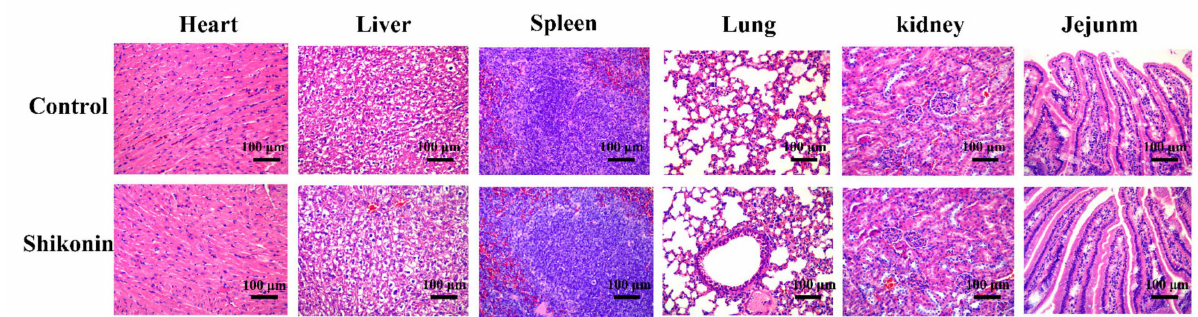
Figure 10. The major organs slice morphology (heart, liver, spleen, lung, kidney and small intestine) after 30 d of treatment with 800 mg/kg shikonin and PBS. The zoom ratio is 12.6%, and the magnification is 200 × .